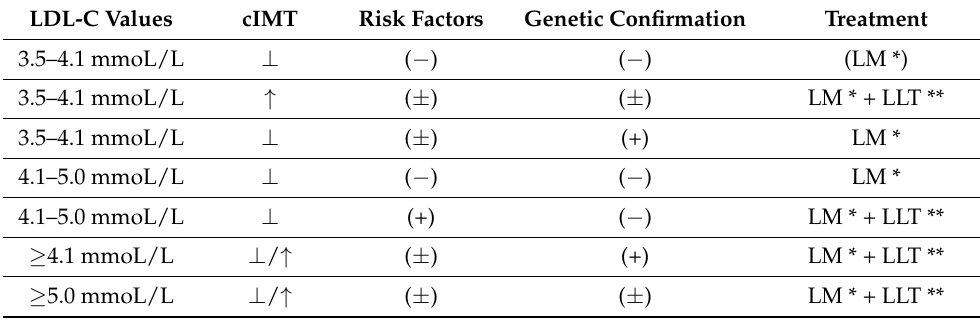
Table 3. The summary of the clinical practice recommendation of the ILEP, MM and